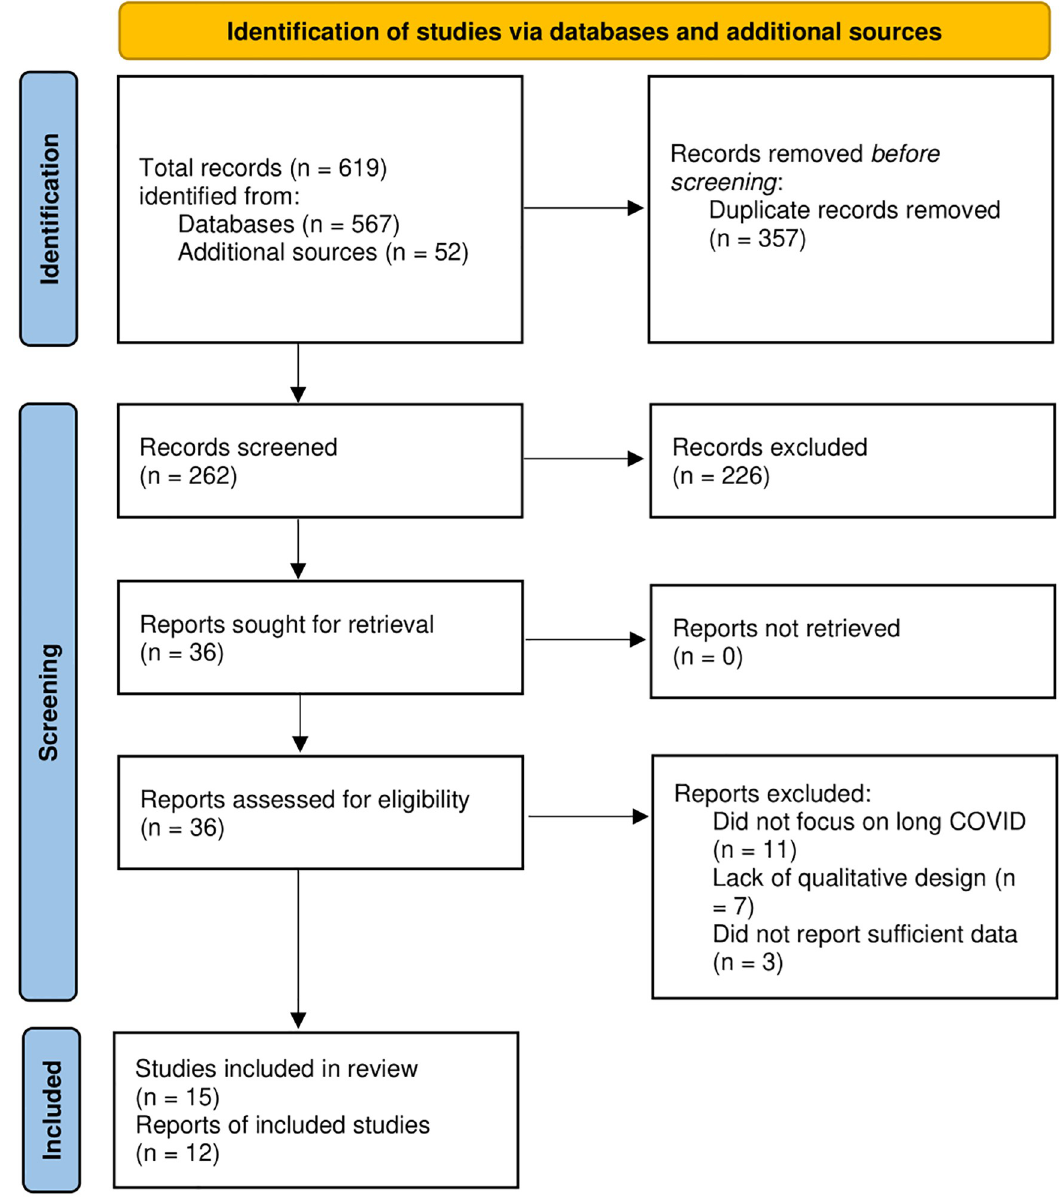
Fig 1. Flow diagram of the literature review